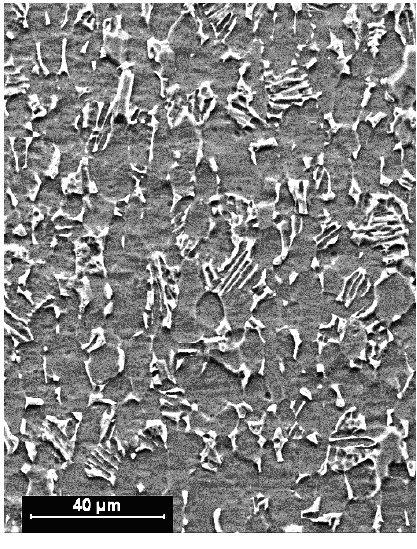
Figure 1. Microstructure of Ti6Al4V alloy